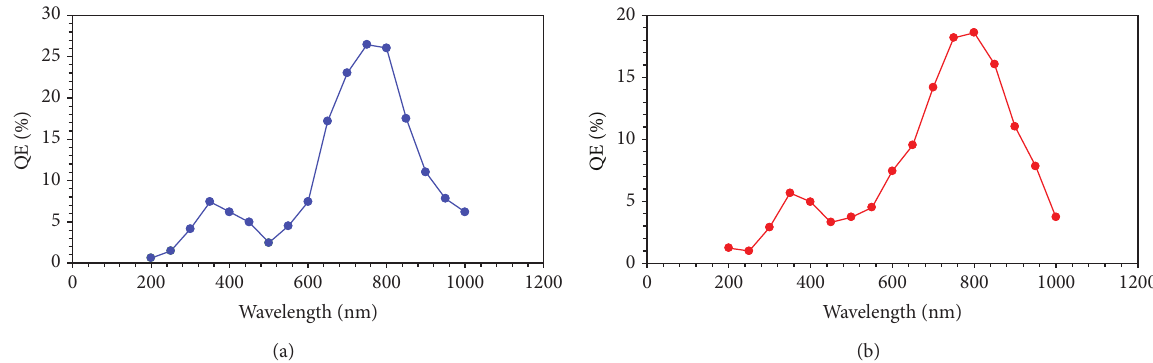
Figure 11: The Specific detectivity as a function of the incident wavelength. (a) (n-SnO 2 /n-Si) device, (b) (n-SnO 2 /p-Si) MIS